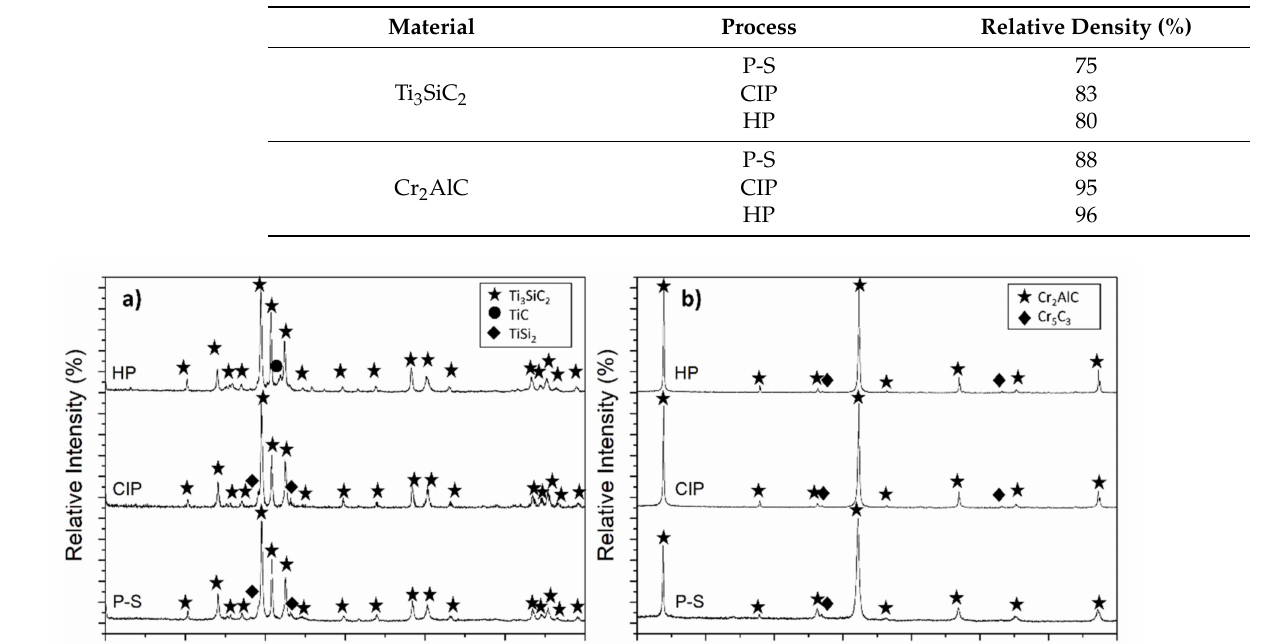
Table 3. The relative densities of the consolidated Ti 3 SiC 2 and Cr 2 AlC MAX phases by press and